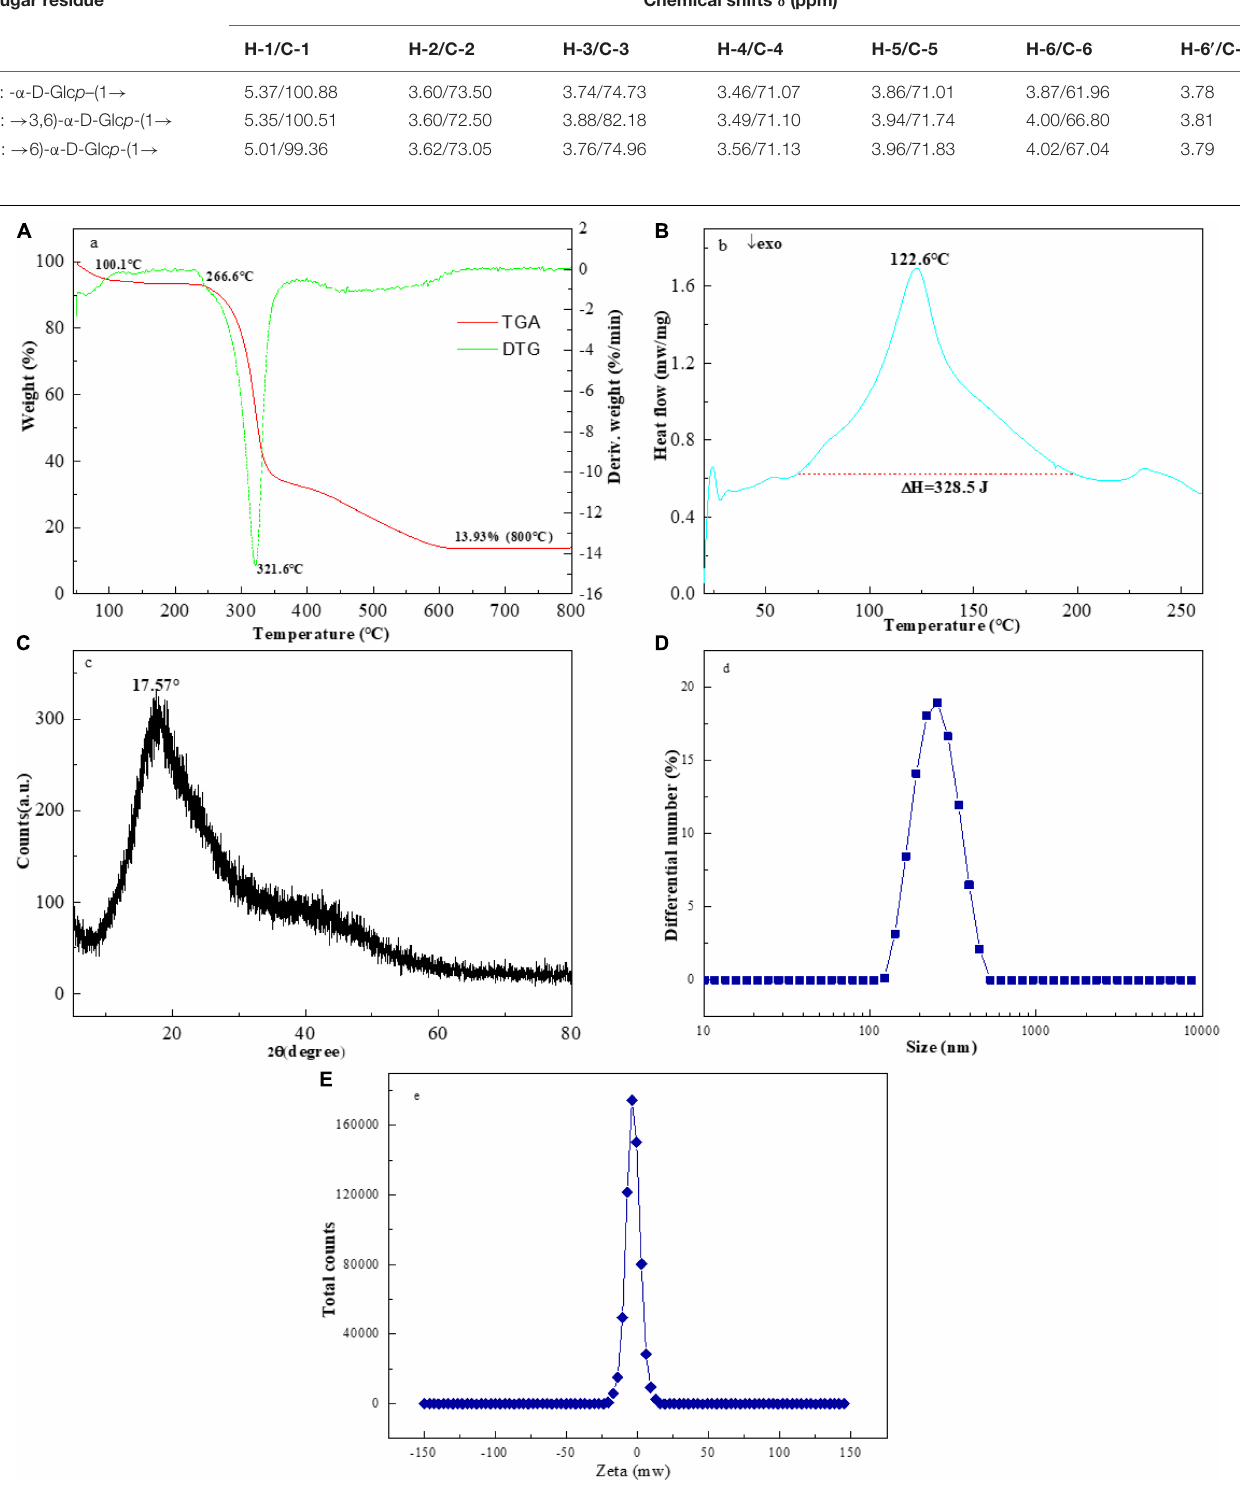
FIGURE 4 | The TGA (A) , (B) DSC and (C) XRD spectra of EPS-F2, (D) Particle size distribution and (E) zeta potential trend of EPS-F2 in ultrapure water.